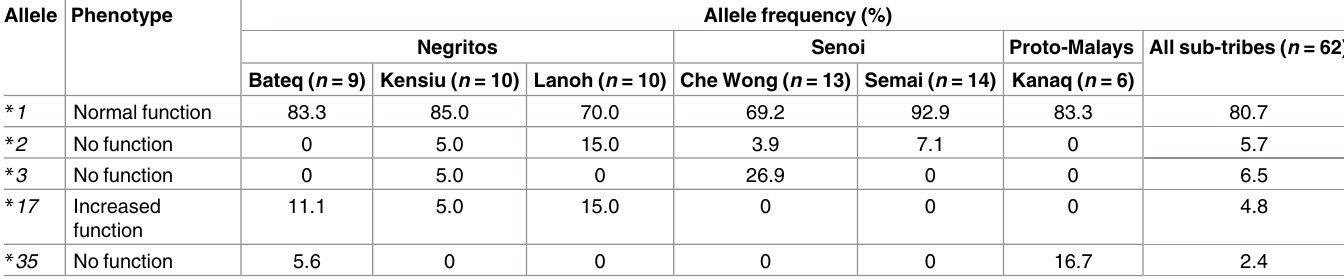
Table 2. Allele frequencies of CYP2C19 in the Orang Asli.